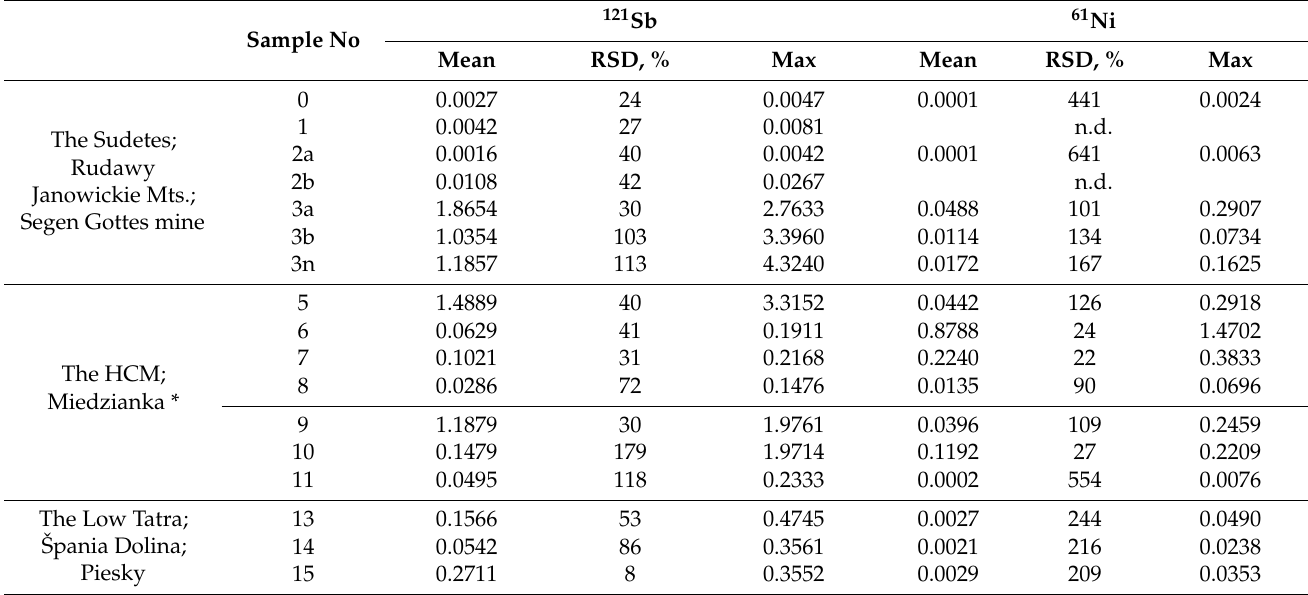
Table 3. Sb and Ni content in copper-based minerals coming from three different deposits, measured by LA-ICP-MS expressed in wt%, normalized to 100%.